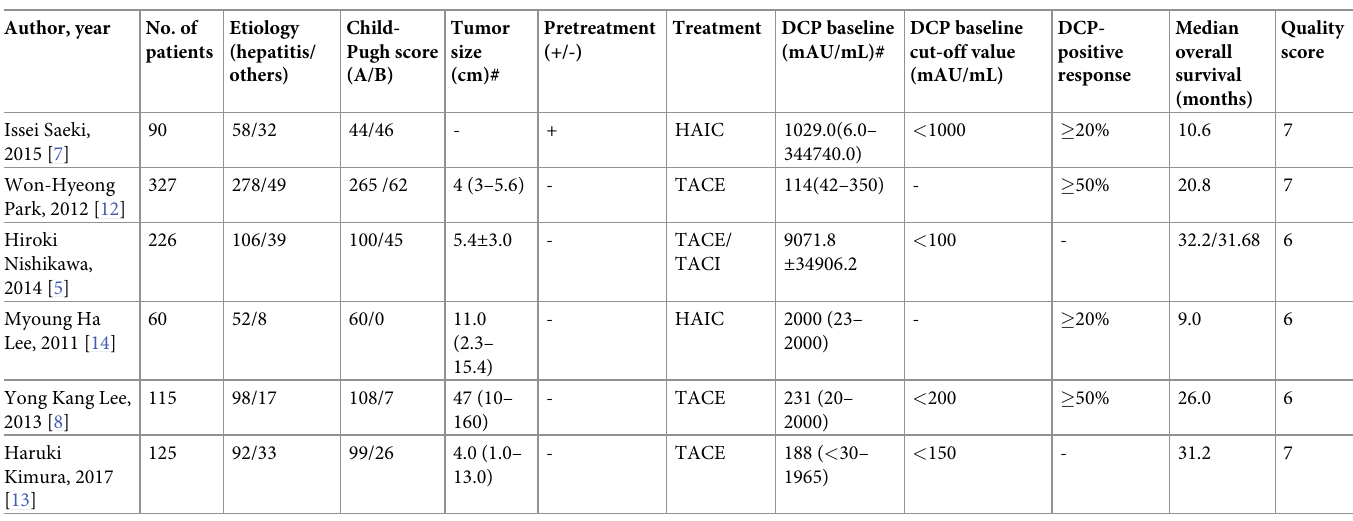
Table 1. Characteristics of included